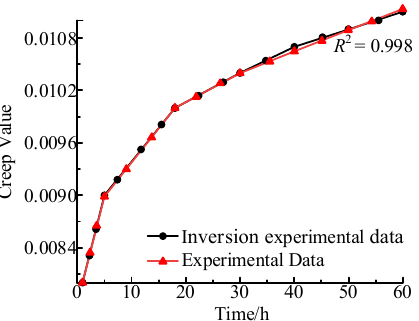
Figure 2. The fitting curve of experimental data and inversion experimental data.